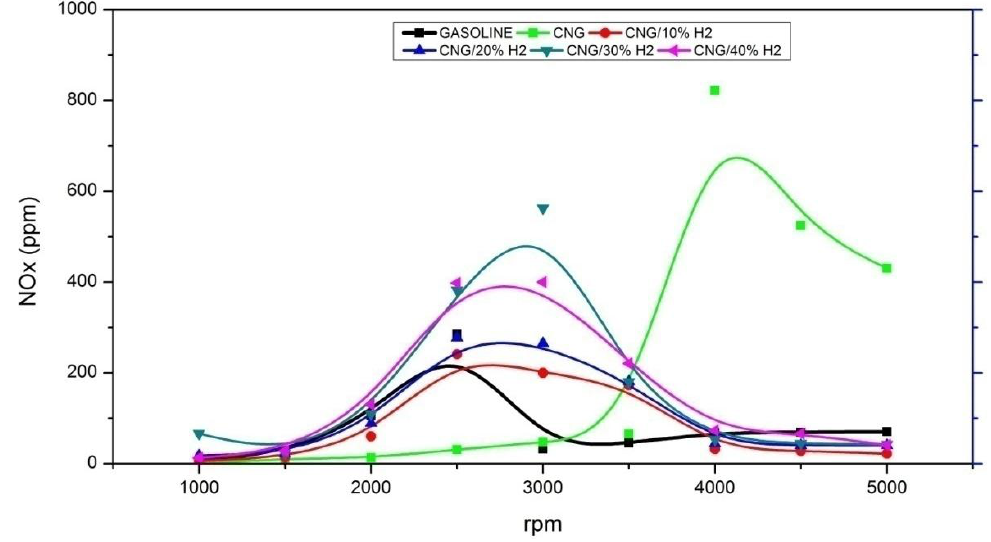
Figure 19. NO X concentration in function of engine speed.